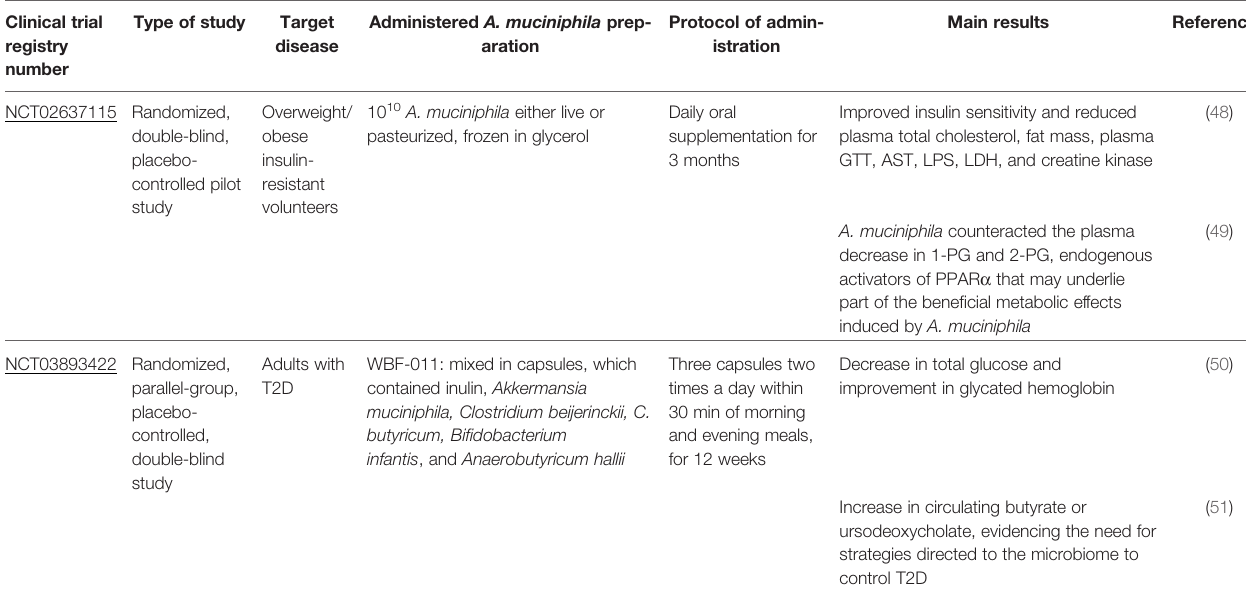
TABLE 1 | Recorded and complete clinical trials using A. muciniphila administration.